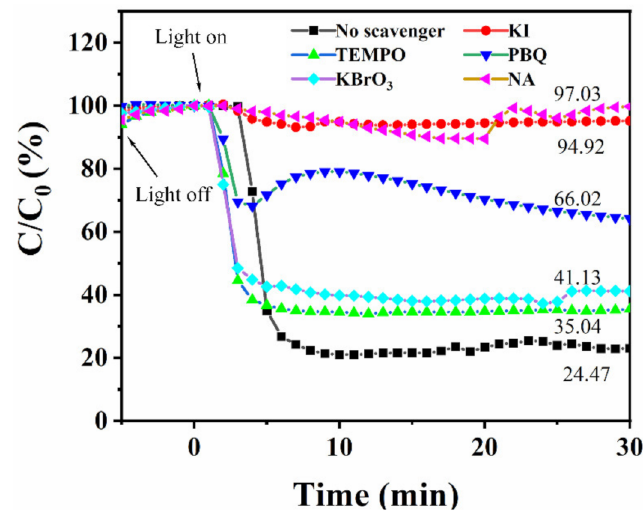
Figure 8. Effect of different radical scavengers on NO removal over